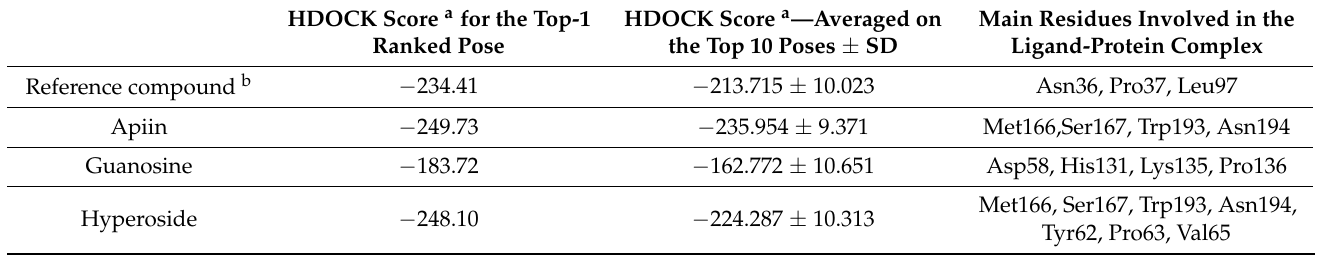
Table 2. Ligand/IL-17 complexation: HDOCK docking scores (for the top ranked poses and averaged on the Top-1–10 poses). The main amino acids involved in the ligand/protein complexes for the Reference compound and each plant metabolite are reported in the last column.